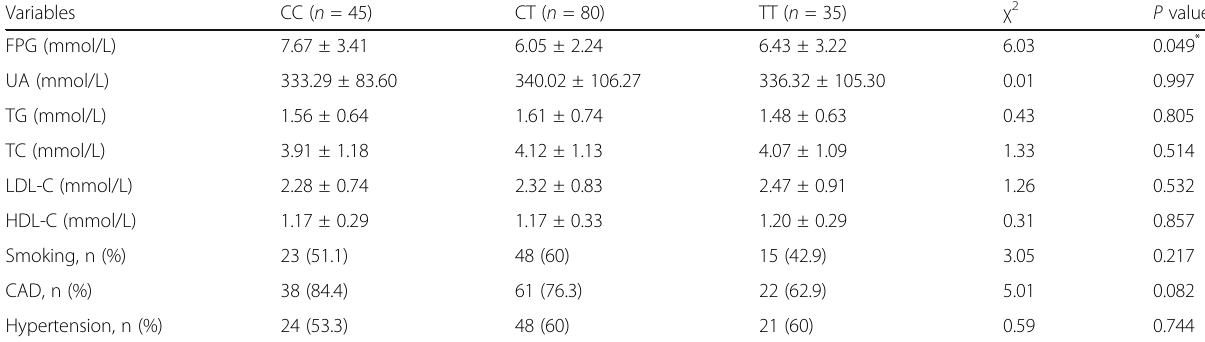
Table 4 Clinical characteristics of the study patients according to the rs189037 polymorphism in the ATM gene Variables CC ( n =